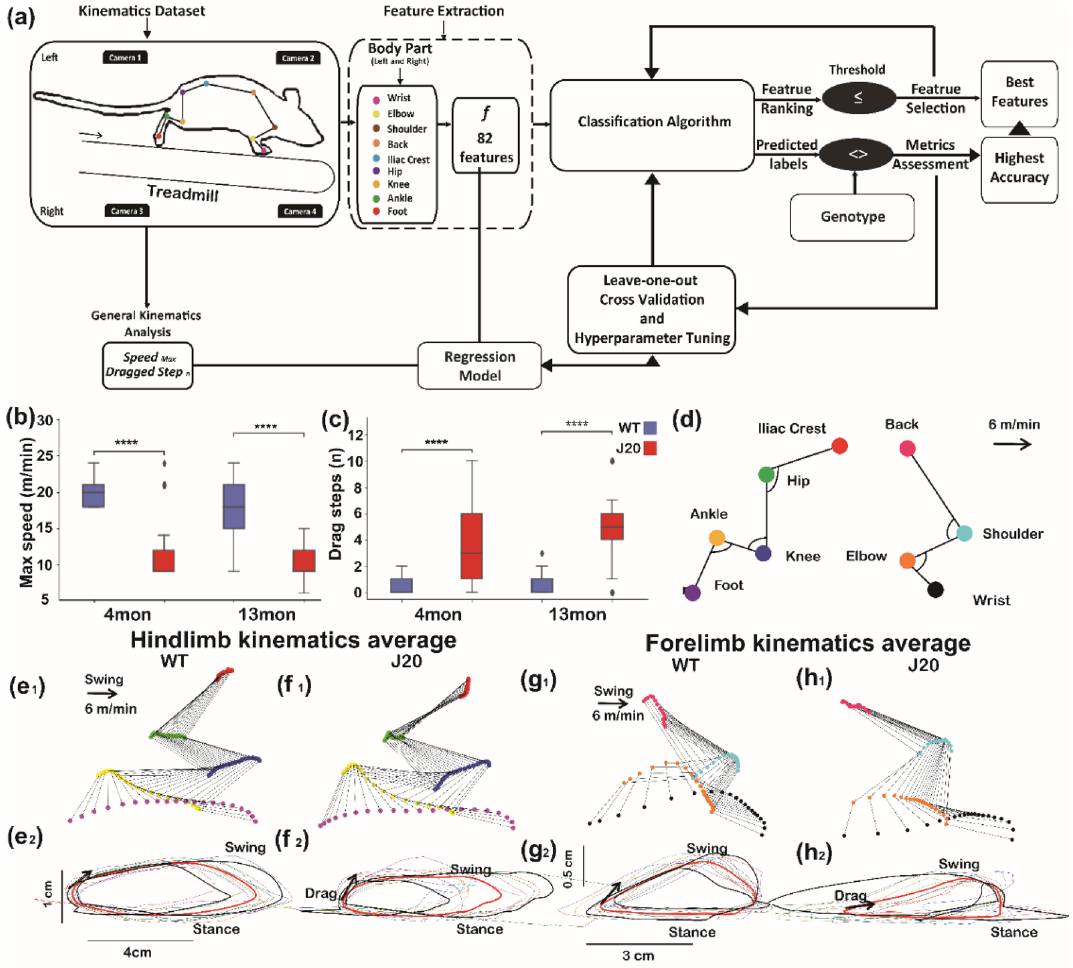
Figure 1. A comparison of kinematic features of locomotion between J20 and wild-type mice. ( a ) Schematic of analytical methods used. Kinematic features were extracted from nine anatomical locations and subsets of the features were optimized for genotype classification of sixteen transgenic mice and fifteen wild-type mice. Regression models were also established to determine the subsets of features predictive of the maximum speed or the drag step number. Kinematic analysis of locomotion revealed a difference in the mean maximum speed ( b ) and mean number of dragged steps ( c ) between J20 and WT mice during locomotion. The mice were stratified into two age-groups: 4-month-old mice (4mon) and 13-month-old mice (13mon; *: P < 0.05, **: P < 0.01, ***: P < 0.0001). Typical angular relationships of the forelimb and hindlimb of mice are shown ( c ). Averaged trajectories of the hindlimbs of WT ( e ) and J20 ( f ) mice as well as the forelimbs of WT ( g ) and J20 ( h ) mice are shown during quadrupedal locomotion using the color scheme for each joint shown in ( d ). Panels generated through Python 3.7, MATLAB 9.2, Power Point (Microsoft office 2016) and Adobe Illustrator